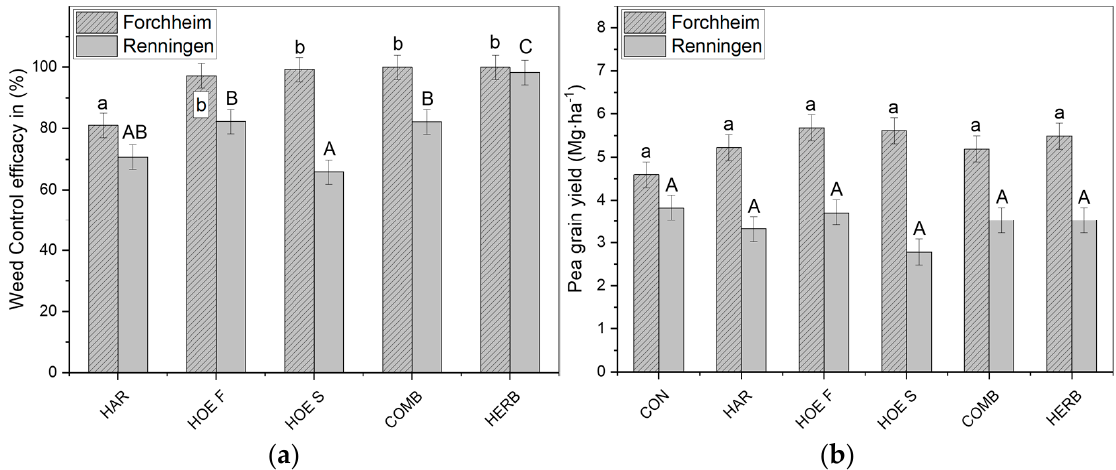
Figure 5. ( a ) Mean weed control efficacy in pea three days after treatment; ( b ) pea grain yield recorded in Forchheim 2018 and Renningen 2019. Variants with the same capital and small letter are not significantly different according to Tukey Honest Significant Difference test (HSD) at α ≤ 0.05. CON = untreated control, HERB = herbicide application, HAR = harrow, HOE S = hoe slow at 3 km ∙ h − 1 , HOE F = hoe fast at 6 km ∙ h − 1 , COMB = combination of harrow and hoe.